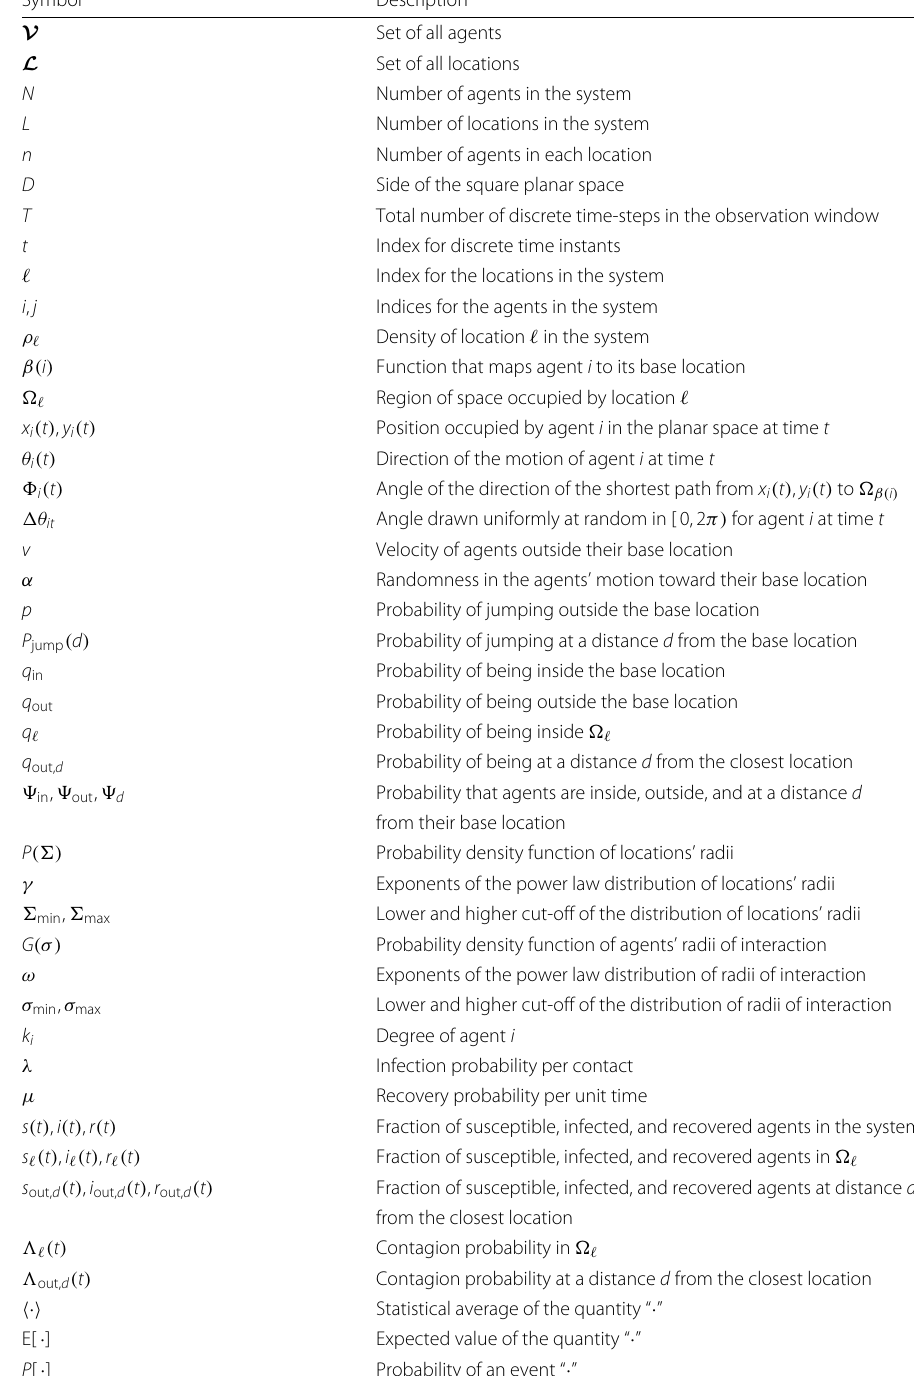
Table 1 Nomenclature of the variables and notation used in the paper